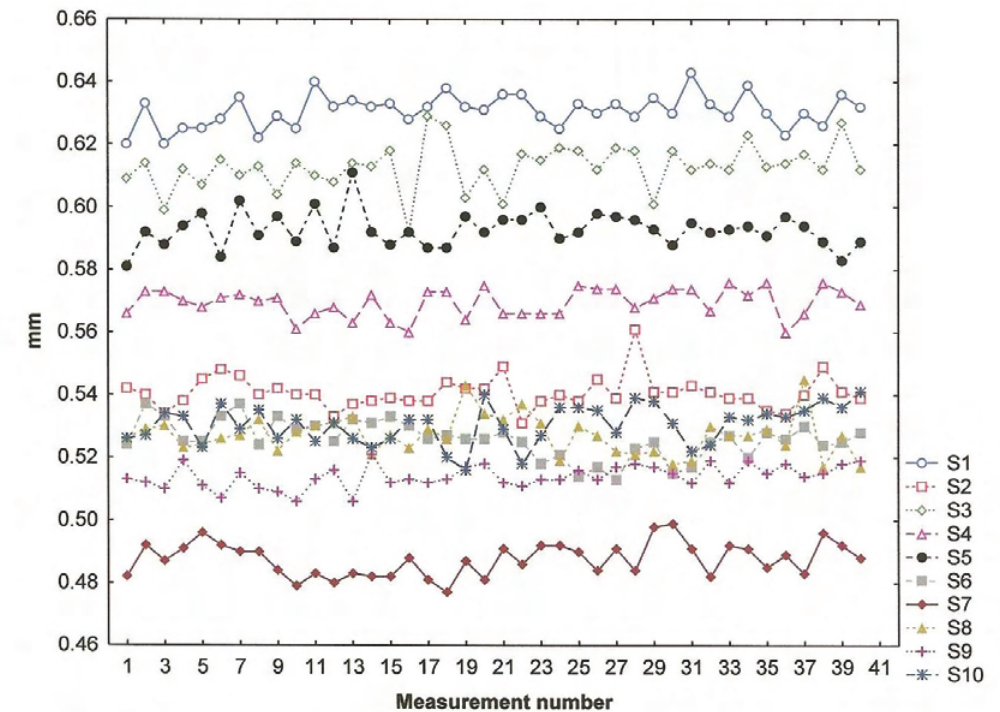
Figure 4. Profile or line plots of temporal variation of the 40 measurements of the CCT (mm) for 10 young subjects are indicated. In - dividual measurements for each subject (S1 to S10) are connected by a line or trajectory. For example, the CCT sample for Subject 1 (the uppermost trajectory in gray-blue with open circles) varies from 0.62 to 0.643 mm (see Table 1 for the minimum and maximum CCT for this particular sample). These trajectories are also useful for identification of possible outliers or extreme measurements within samples. Each trajectory represents a time interval of about 50 minutes.